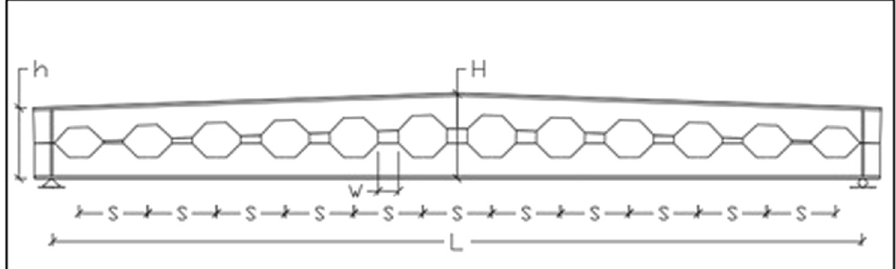
Figure 5: Dimensions and notations of TCB specimens.